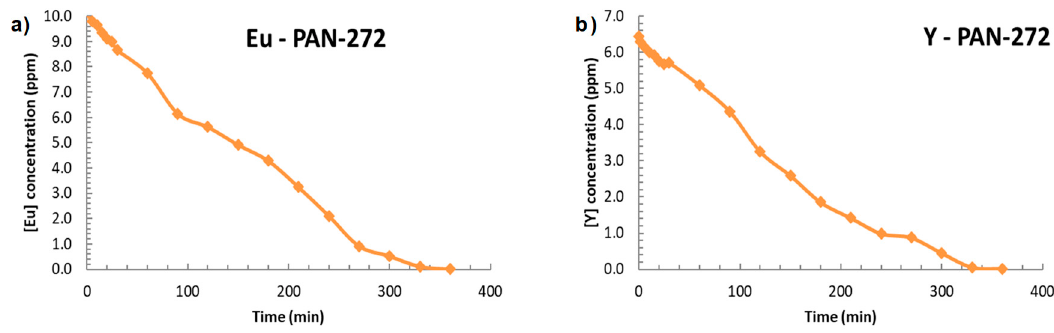
Figure 12. Adsorption in continuous mode of PAN-272 nanofibrous for ( a ) Eu(III) and ( b ) Y(III).